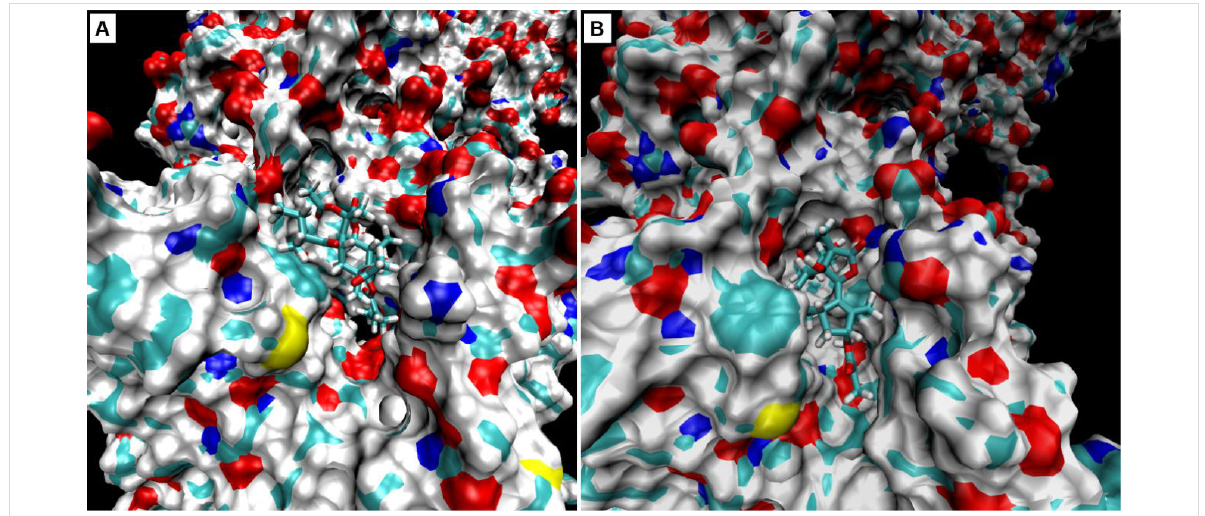
Figure 5: Molecular surface representation of sarco/endoplasmic reticulum Ca 2+ ATPase binding pocket with A) archangelolide ( 1 ) and B) trilobolide ( 2 ) after molecular dynamic simulations. SURF function and probe size 1.4 Å were used. SURF function was written by Amitabh Varshney in Univer- sity of North Carolina. The images were created using VMD software, version 1.9.2.